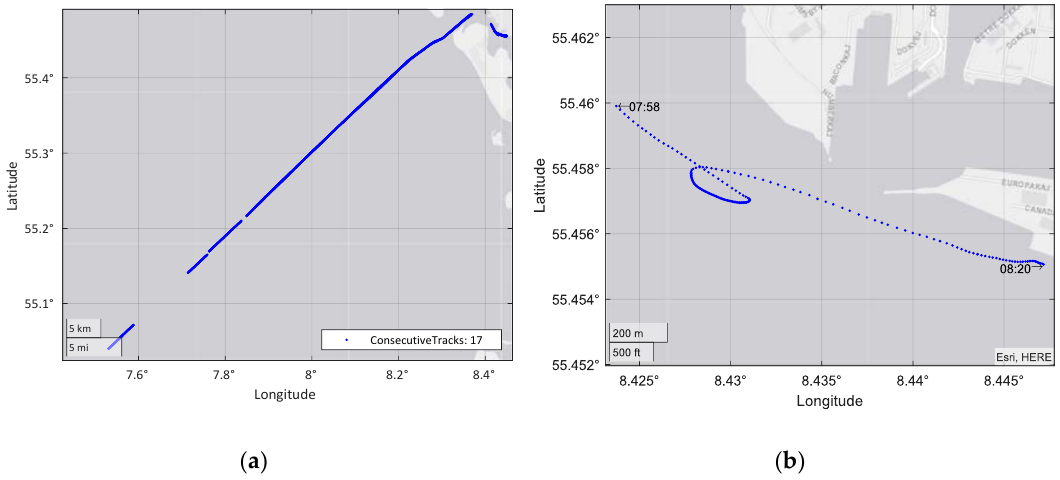
Figure 6. ( a ) Cleaning process of the example ship; ( b ) Selected track example.